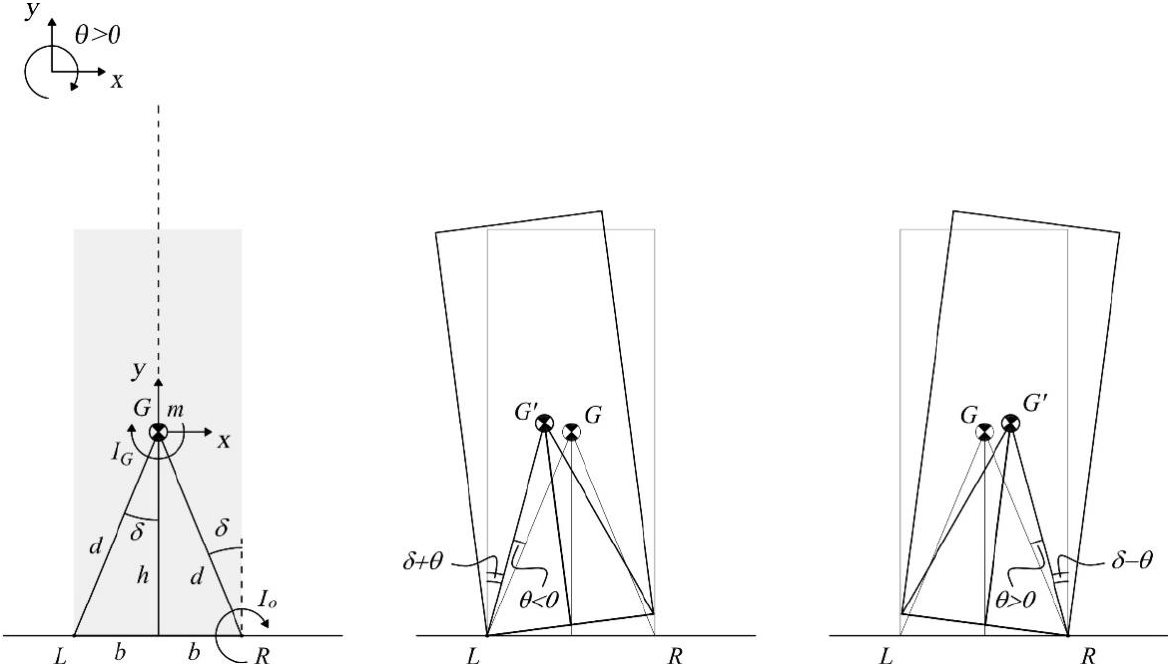
Figure 1. Simple Rocking Model.